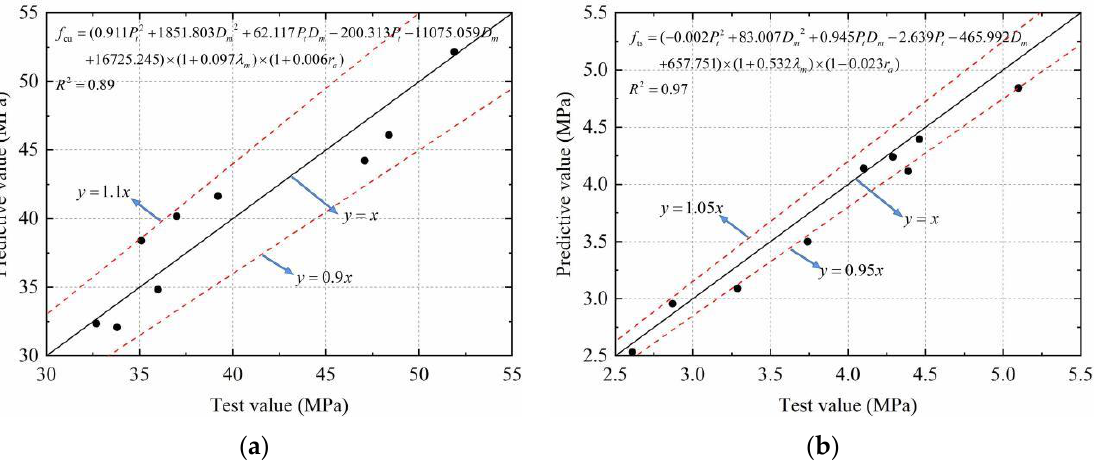
Figure 21. Multiple regression calculation of SFRRC strength: ( a ) Compressive strength; ( b ) Splitting tensile strength.